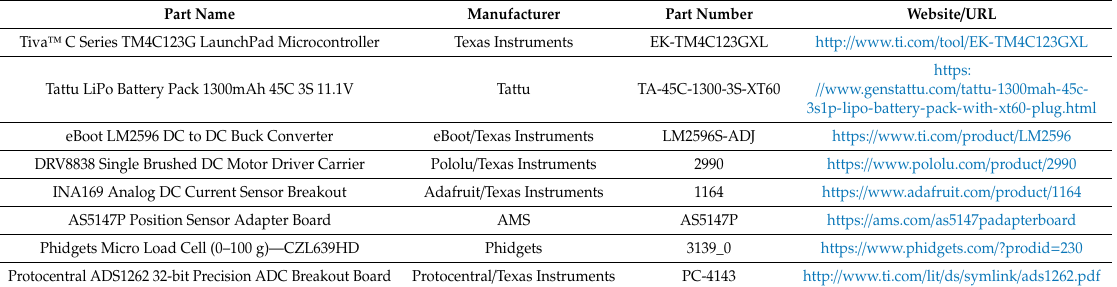
Table A1. List of hardware